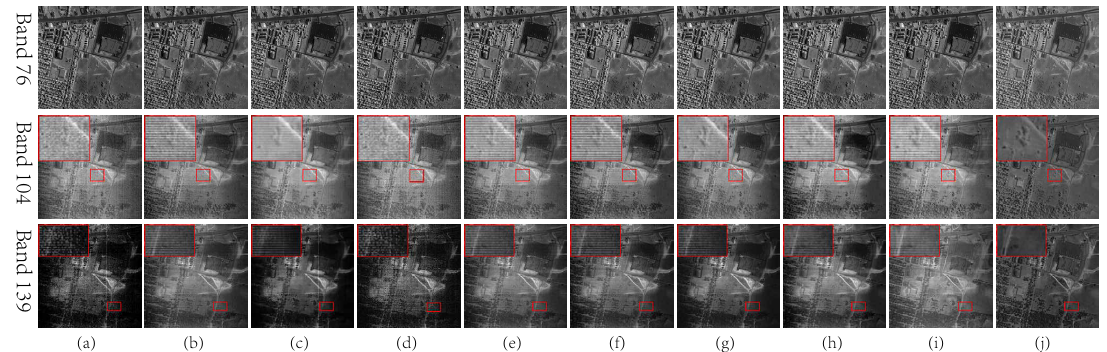
Figure 8. From top to bottom: restoration results of bands 76, 104 and 139 of the real Urban HSI dataset. ( a ) Original HSI; ( b ) SVD; ( c ) BM4D; ( d ) TDL; ( e ) WNNM; ( f ) WSNM; ( g ) LRMR; ( h ) LRTV; ( i ) NMoG; ( j )